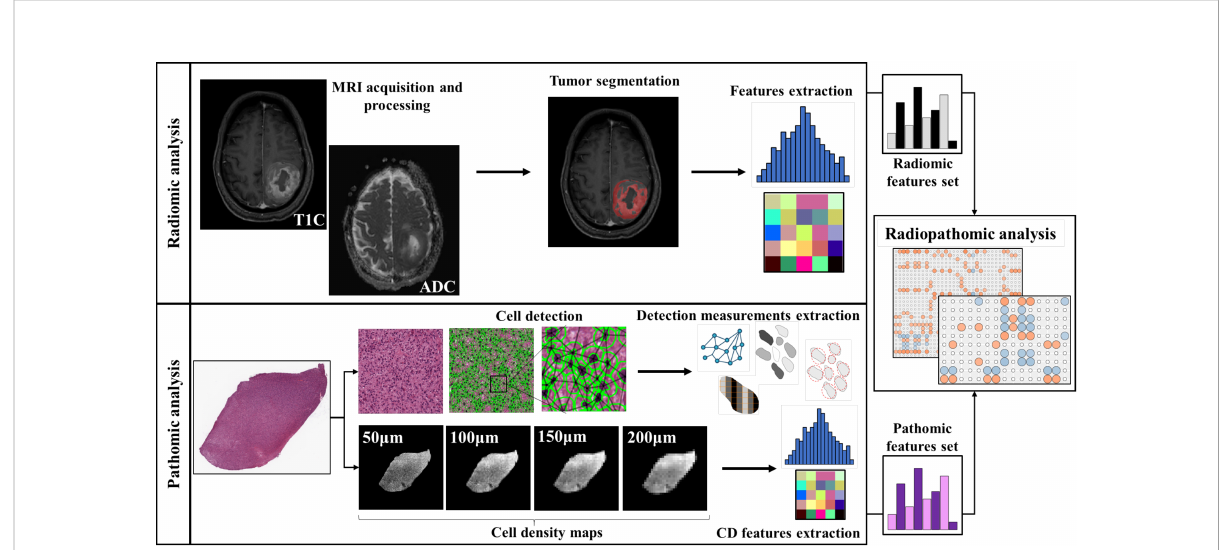
FIGURE 1 Work fl ow of the radiopathomic analysis implemented in the study. On the fi rst row the radiomic analysis steps. On the second row the pathomic analysis